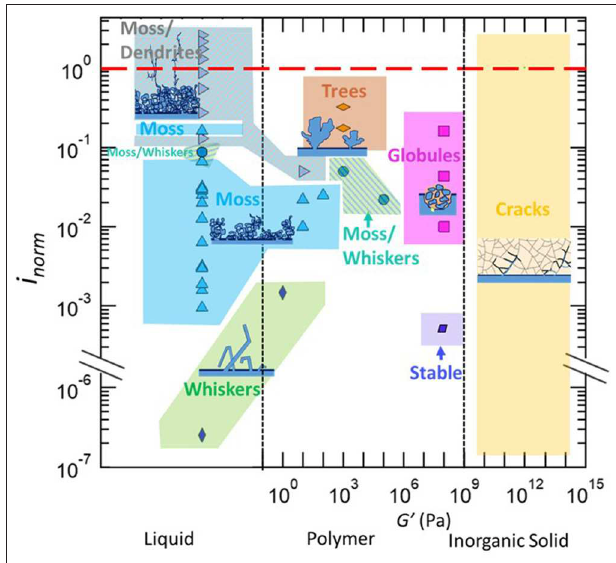
FIGURE 1 | Morphology data of lithium protrusions plotted as a function of the current density normalized by the limiting current density, i norm , vs. the electrolyte type and storage shear modulus, G’ . Continuous regions of morphologies are shaded with a solid color, and coexisting morphologies are denoted by hatched regions. The references from where the information is obtained is in Supporting Information, Supplementary Figure 1